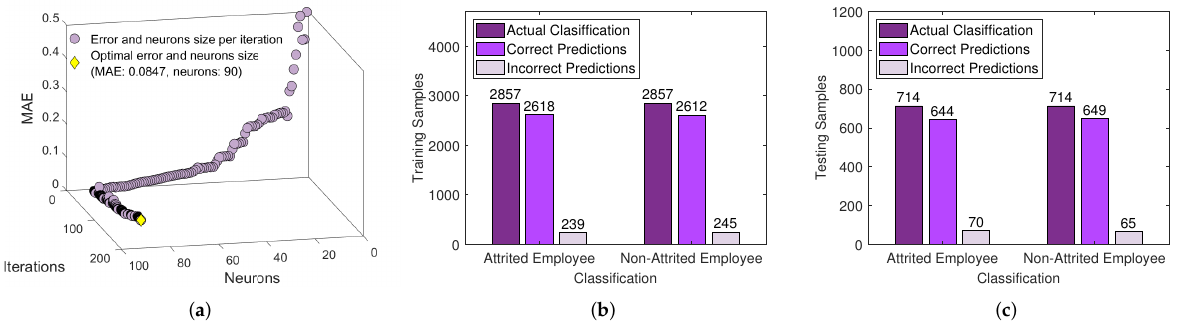
Figure 4. Training iterations and classification results of the FCI-WASD on EA.I. ( a ) EA.I: Training iterations; ( b ) EA.I: Training results; ( c ) EA.I: Testing